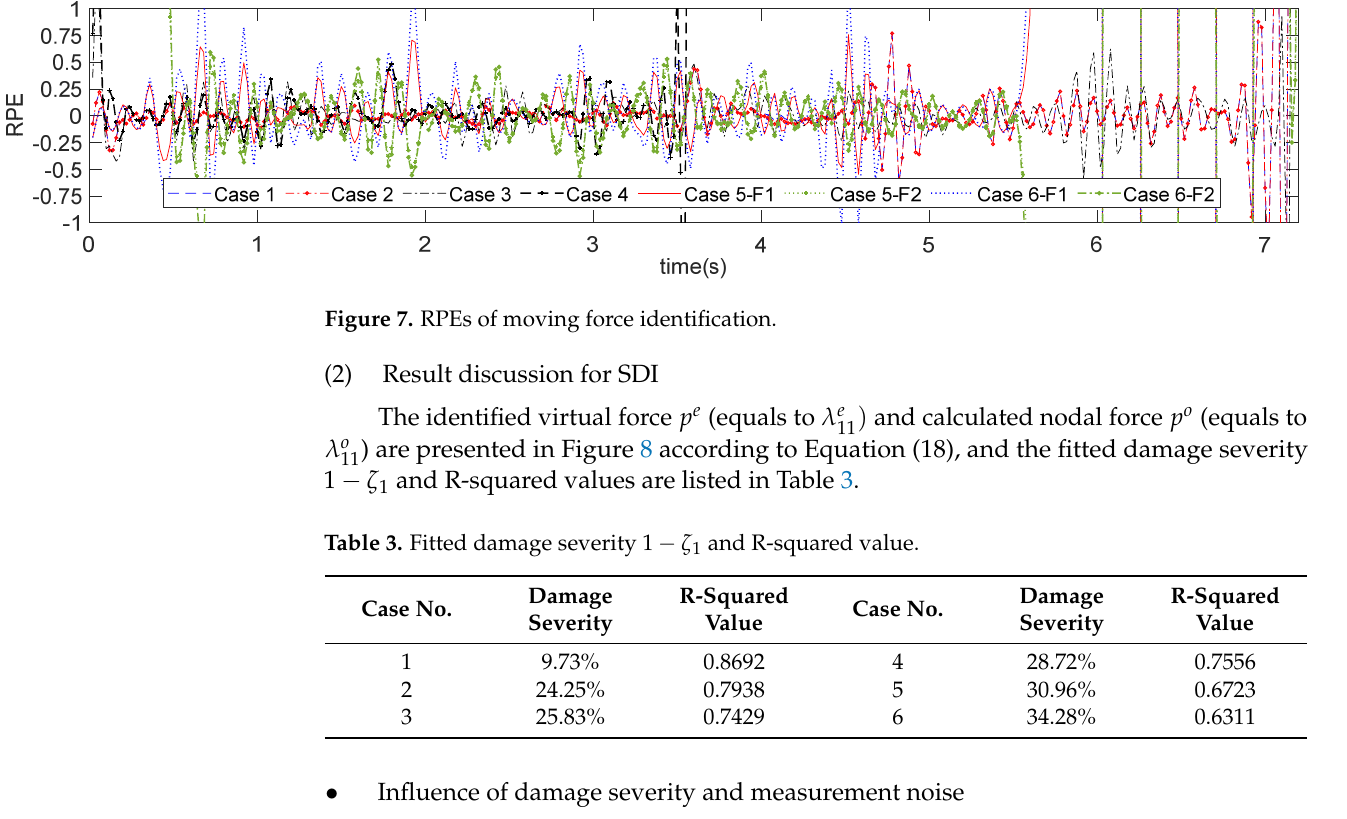
Figure 6. Moving force determination results in the synchronized assessment. ( a ) Cases 1 and 2; ( b ) Case 3; ( c ) Case 4; ( d ) Case 5; ( e ) Case 6.